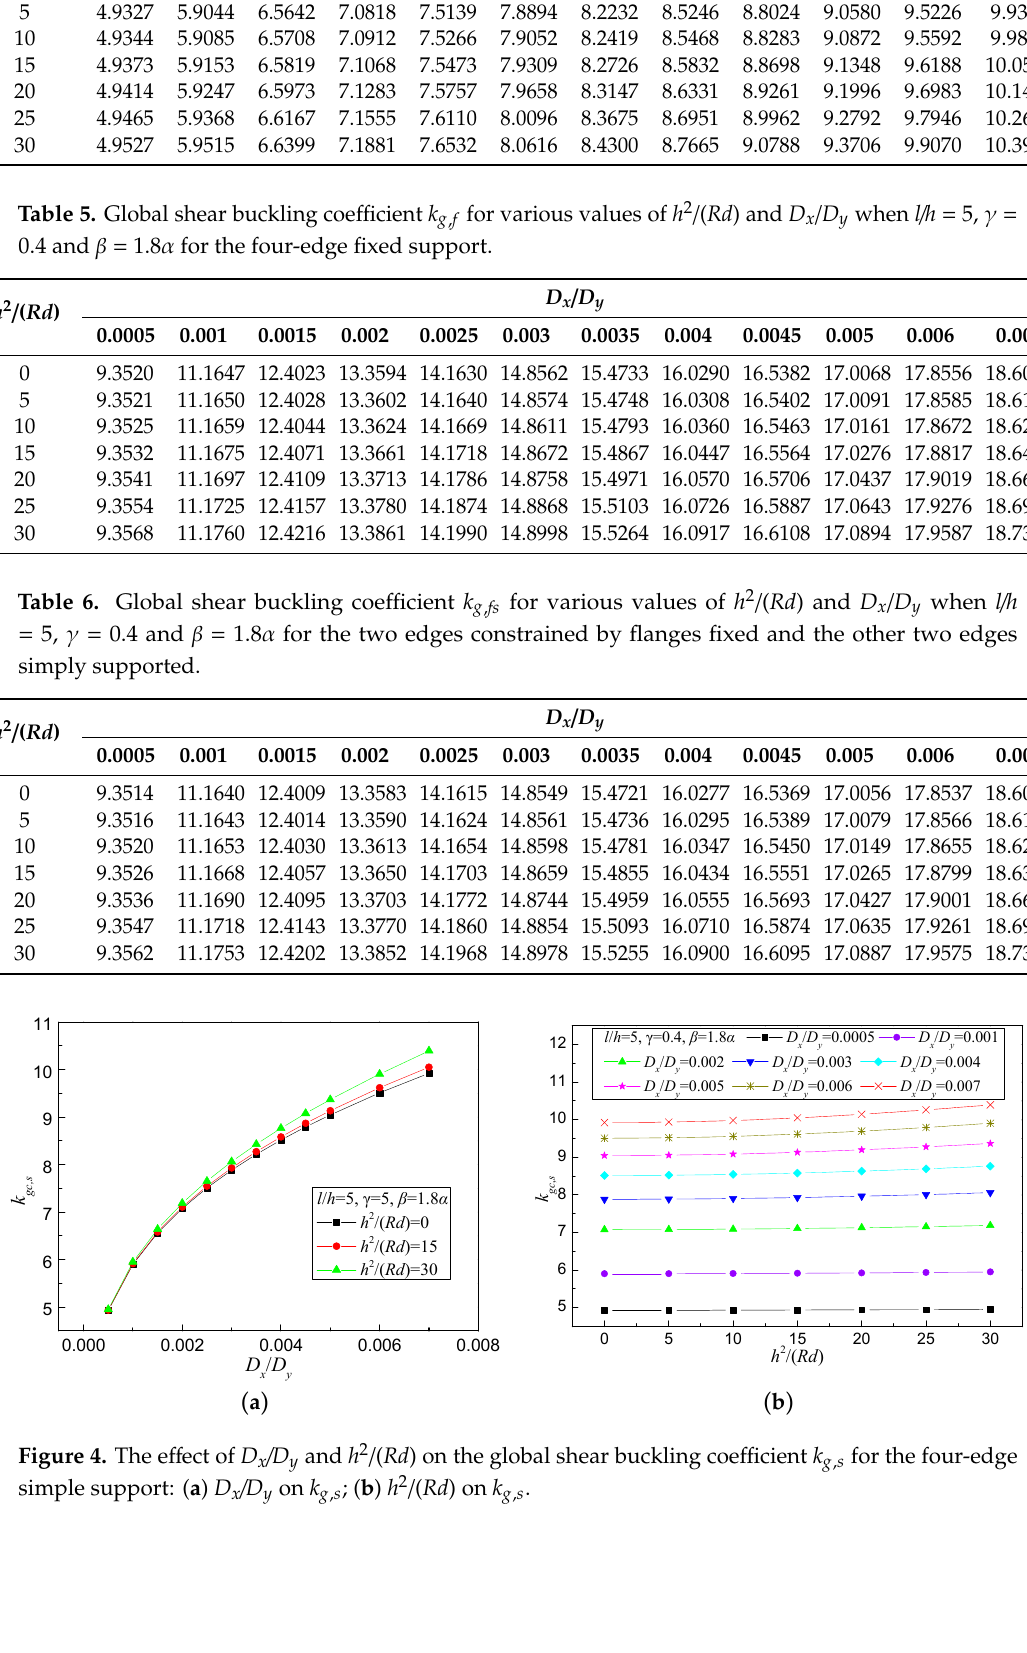
Table 4. Global shear buckling coe ffi cient k g , s for various values of h 2 / ( Rd ) and D x / D y when l / h = 5, γ = 0.4 and β = 1.8 α for the four-edge simple support.